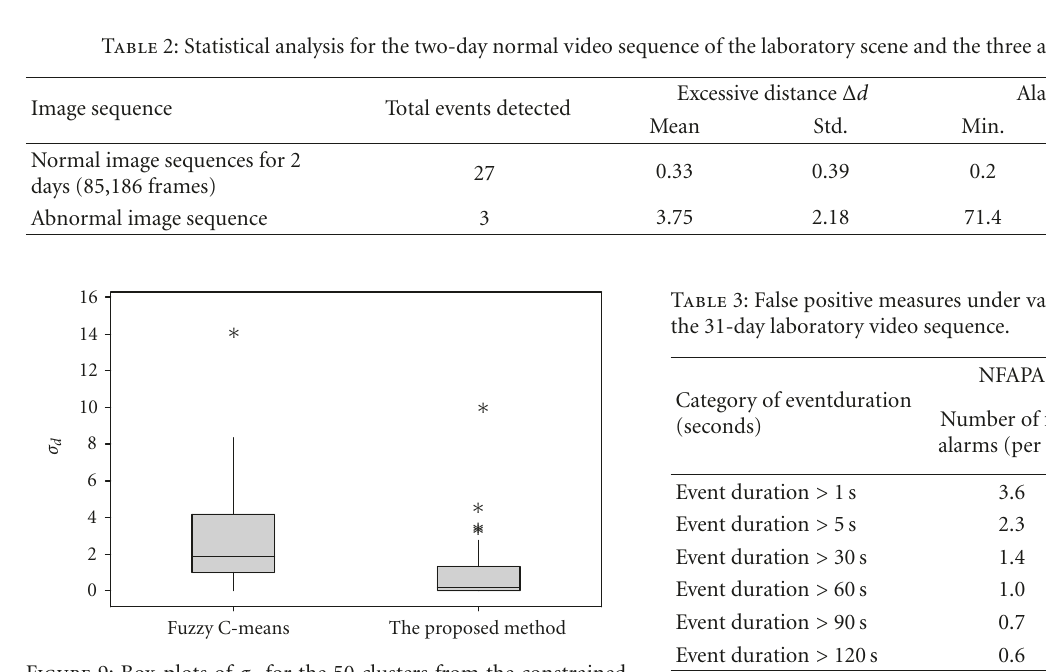
Figure 9: Box-plots of σ d for the 50 clusters from the constrained clustering model and the conventional FCM.